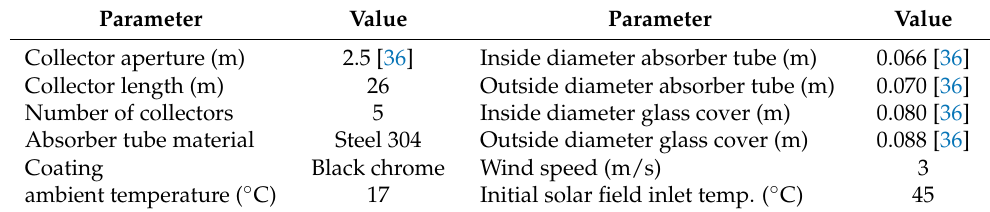
Table 5. Design parameters for the solar field.